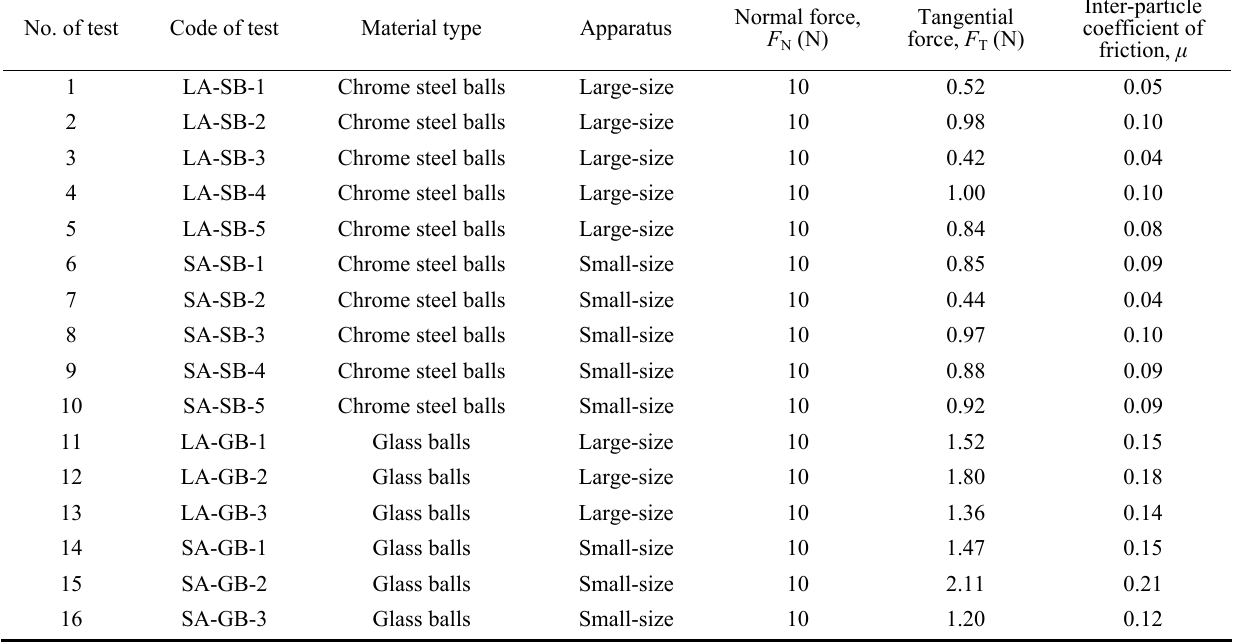
Table 1 Inter-particle sliding tests on chrome steel balls and glass balls.